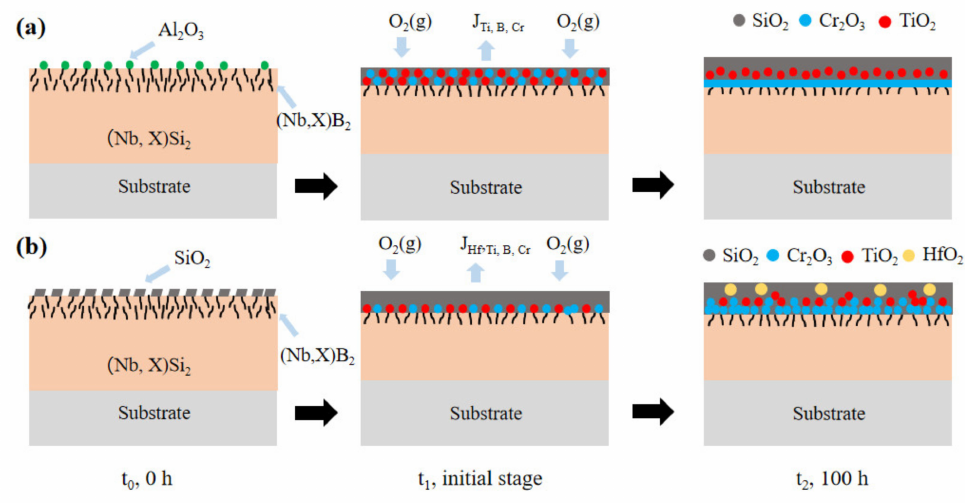
Figure 8. Schematic drawing of oxidation process of B modified silicides coatings at 1250 ◦ C prepared with Al 2 O 3 ( a ) and SiO 2 ( b